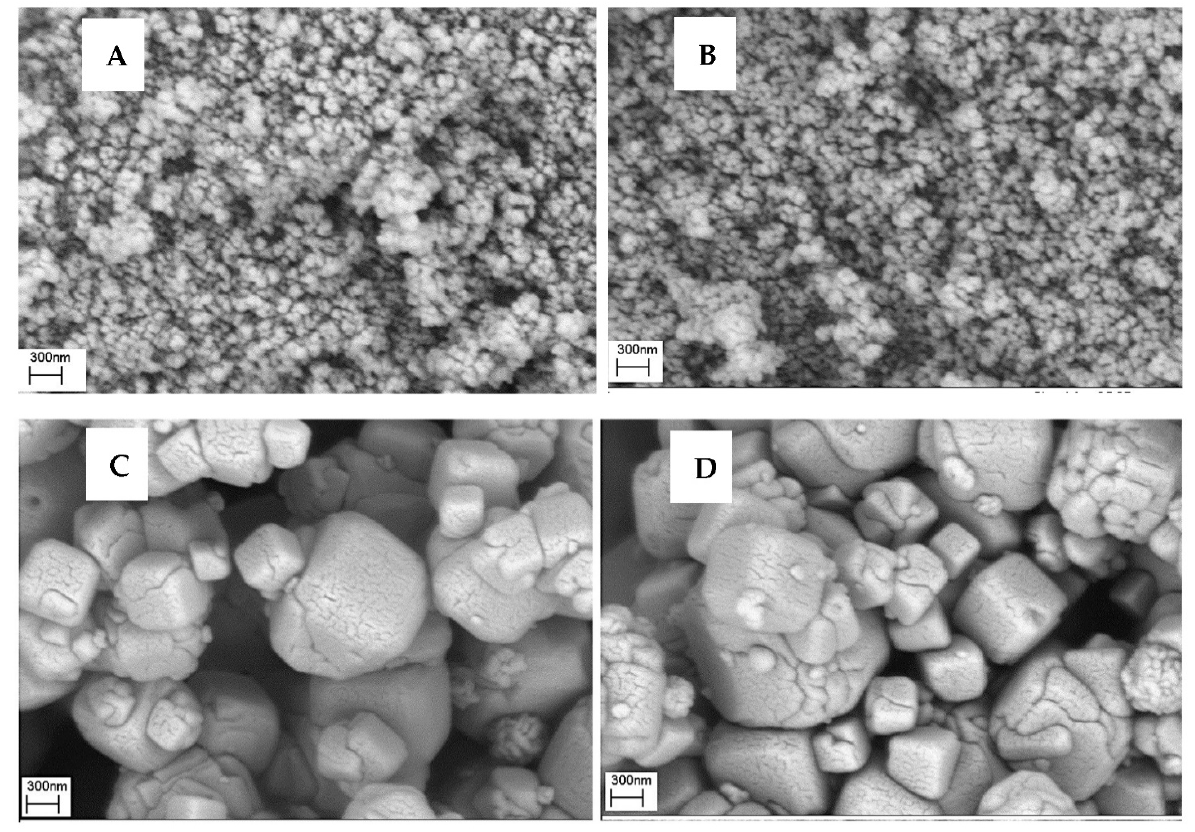
Figure 3. Scanning electron microscopy (SEM) micrographs (( A ): MCM-41; ( B ): MCM-41-essential